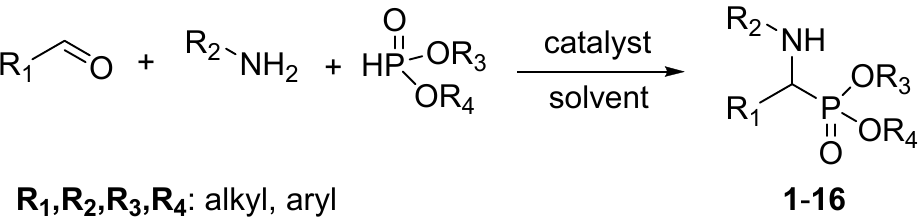
Scheme 1. Enzyme-catalyzed synthesis of α -aminophosphonates 1 – 16 Table 1. Model Kabachnik–Fields reaction catalyzed by enzymes. [a] Optimization studies.